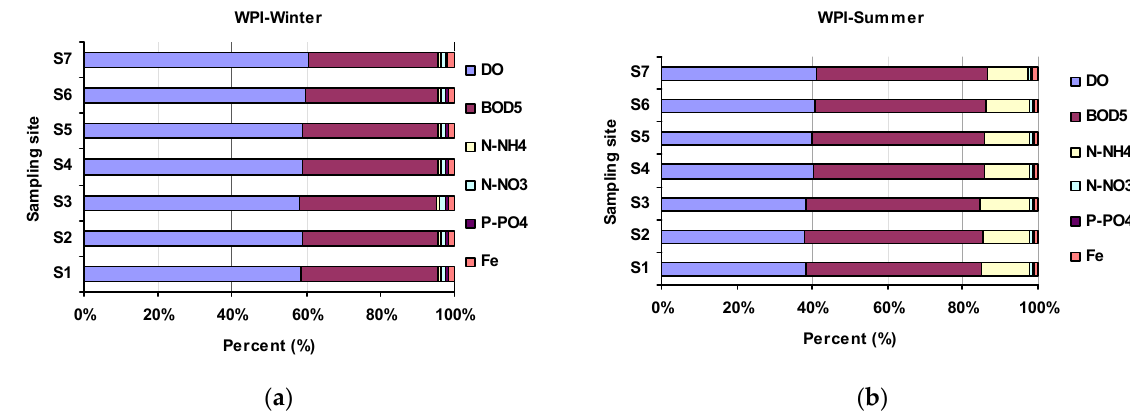
Figure 5. The weight of each parameter to the WPI values recorded in winter ( a ) and summer ( b ).